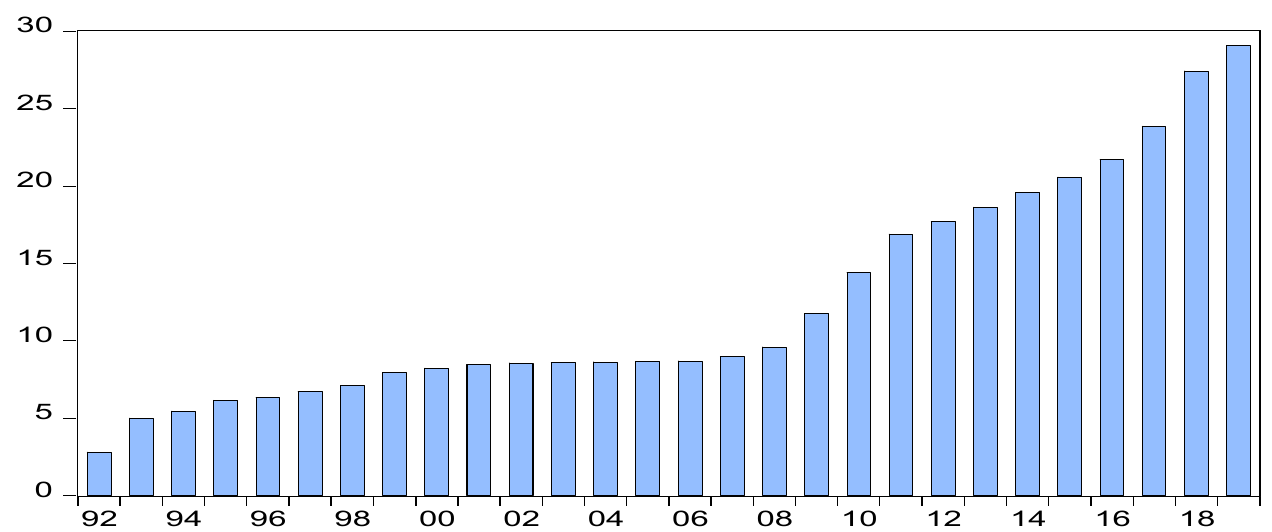
Figure 3. The movement of the exchange rate (ER) in Ethiopia. Source: Constructed by authors using E-view 10.